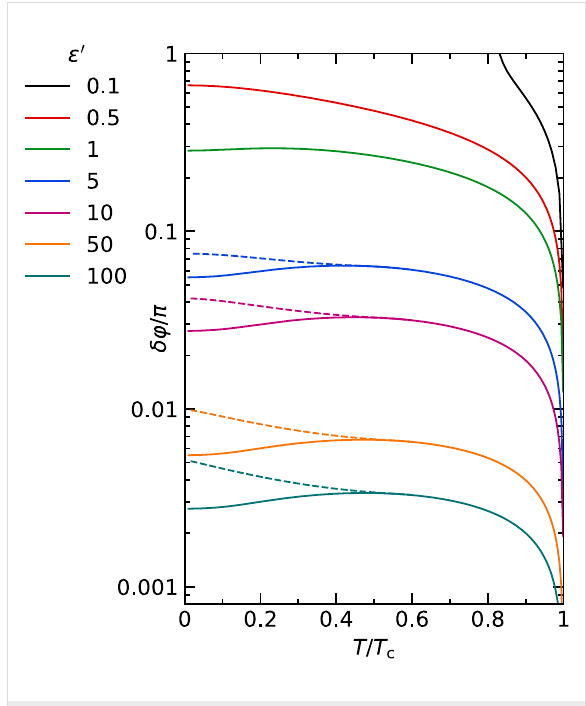
Figure 2: Phase diagram of the spin mixing angle δφ / π as a function of the normalized temperature T / T c for values of ε ’ =